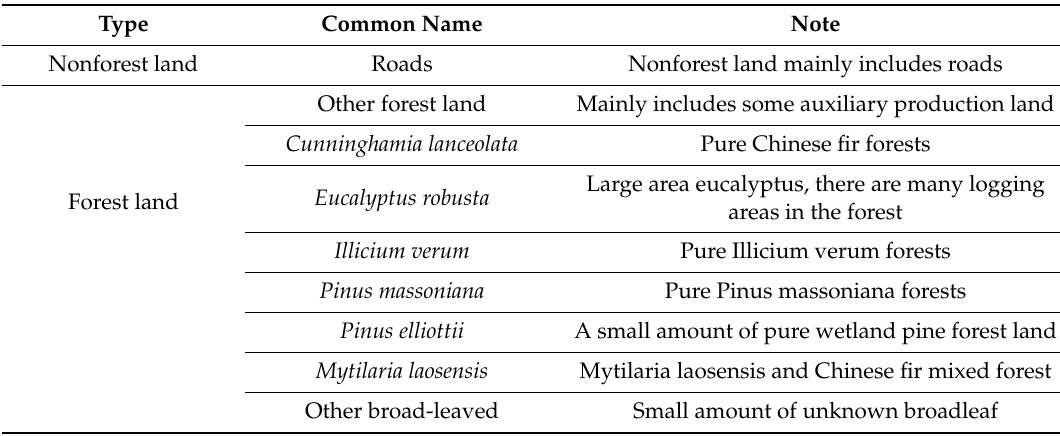
Figure 1. Geographical location of Gaofeng Forest Farm Boundary ( top left ), the CCD orthophoto of Jiepai Field and study area ( bottom left ), the CCD orthophoto of aerial area ( top right ), the CCD orthophoto of study area ( bottom right ). Table 1. Classification system of the study area (Figure 1 (bottom right)).